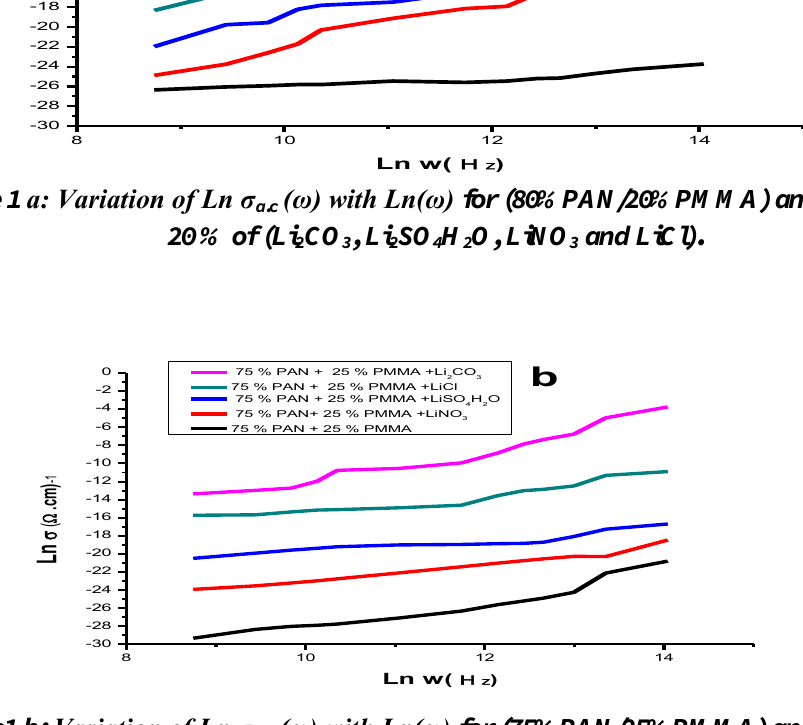
Figure1 b: Variation of Ln σ (ω) with Ln(ω) for (75%PAN/25%PMMA) and doped with a.c